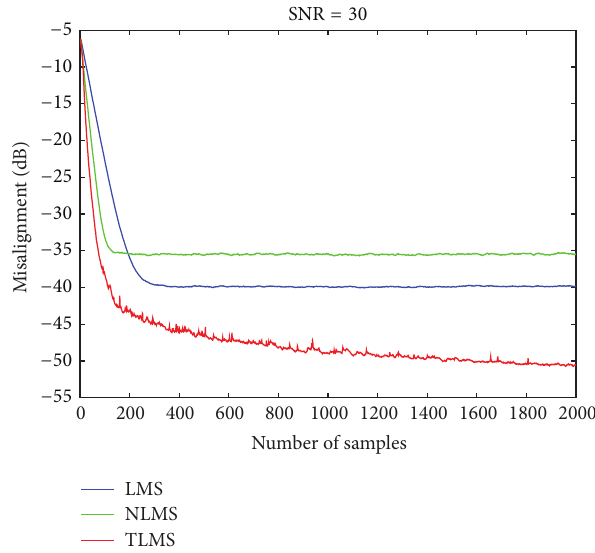
Figure 4: Comparison of TLMS, LMS, and NLMS